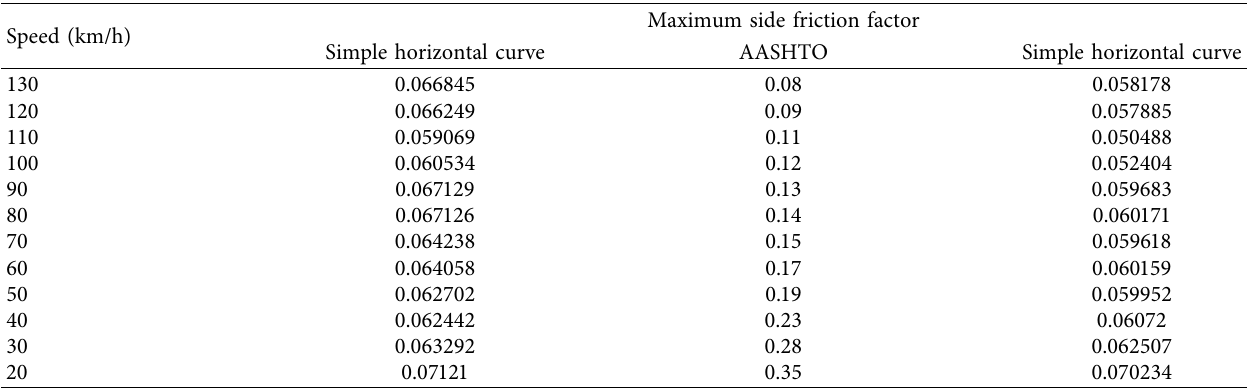
Table 18: Comparison of the maximum side friction factor for SUV between simple and spiral horizontal curves and AASHTO rec- ommended values at a radius of 1.1R.